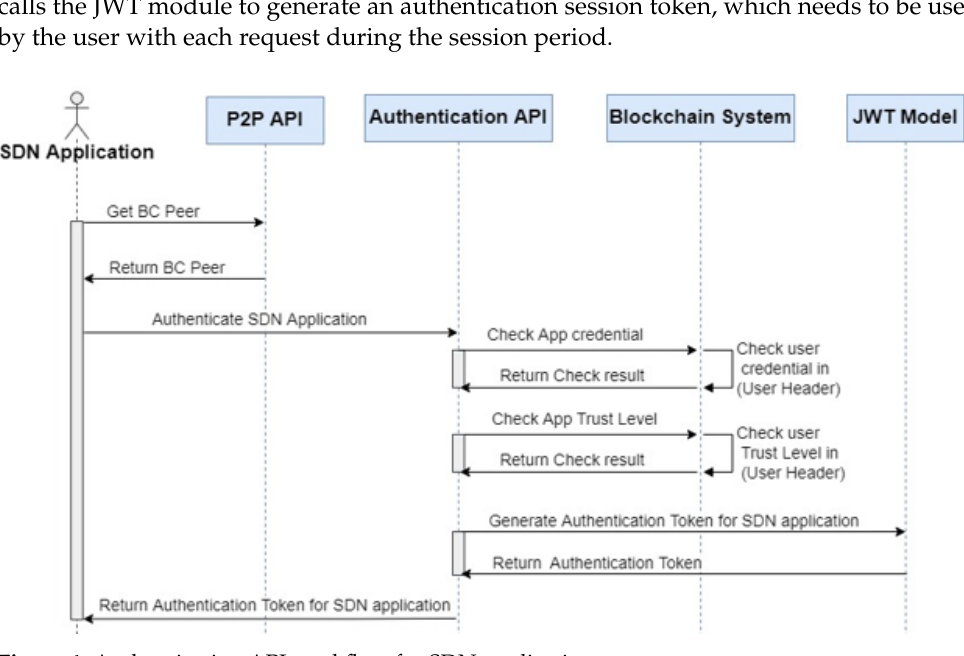
Figure 4. Authentication API workflow for SDN